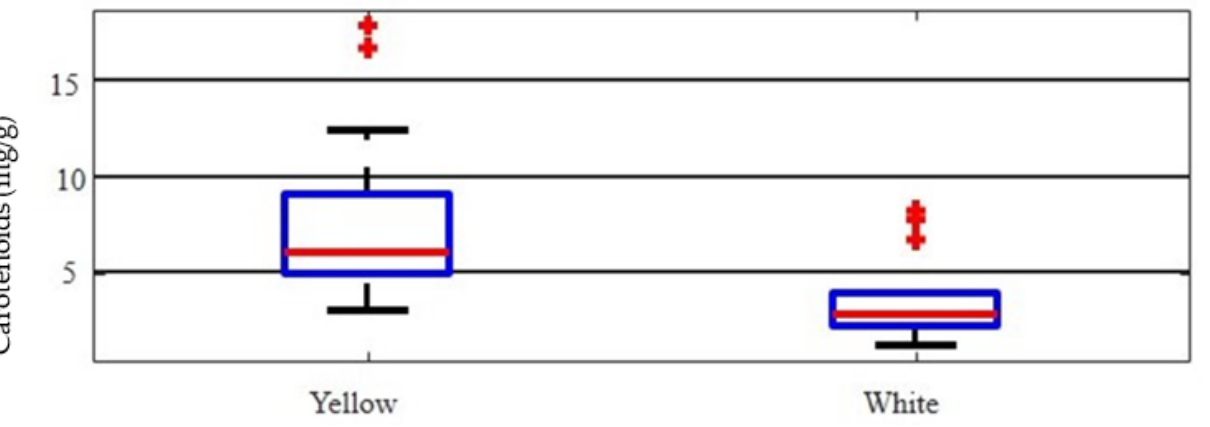
Figure 4. Box plots for total carotenoid contents (mg g − 1 ) of yellow- and white-flesh fruits. The central line displays the median, the bottom and top of the box are the first and third quartiles, respectively. Gill et al. [24] reported carotenoid levels of 128.4–9.6 µ g/100 g (yellow white nec- tarines), and 23.2–131.6 µ g/100 g (white and yellow peaches). Vizzotto et al. [52] analyzed the carotenoid content of 19 peach genotypes. In this case, the accumulation of carotenoids in yellow-fleshed peaches was 35 times greater (2.80 mg/100 g) than in white fruits (0.08 mg/100